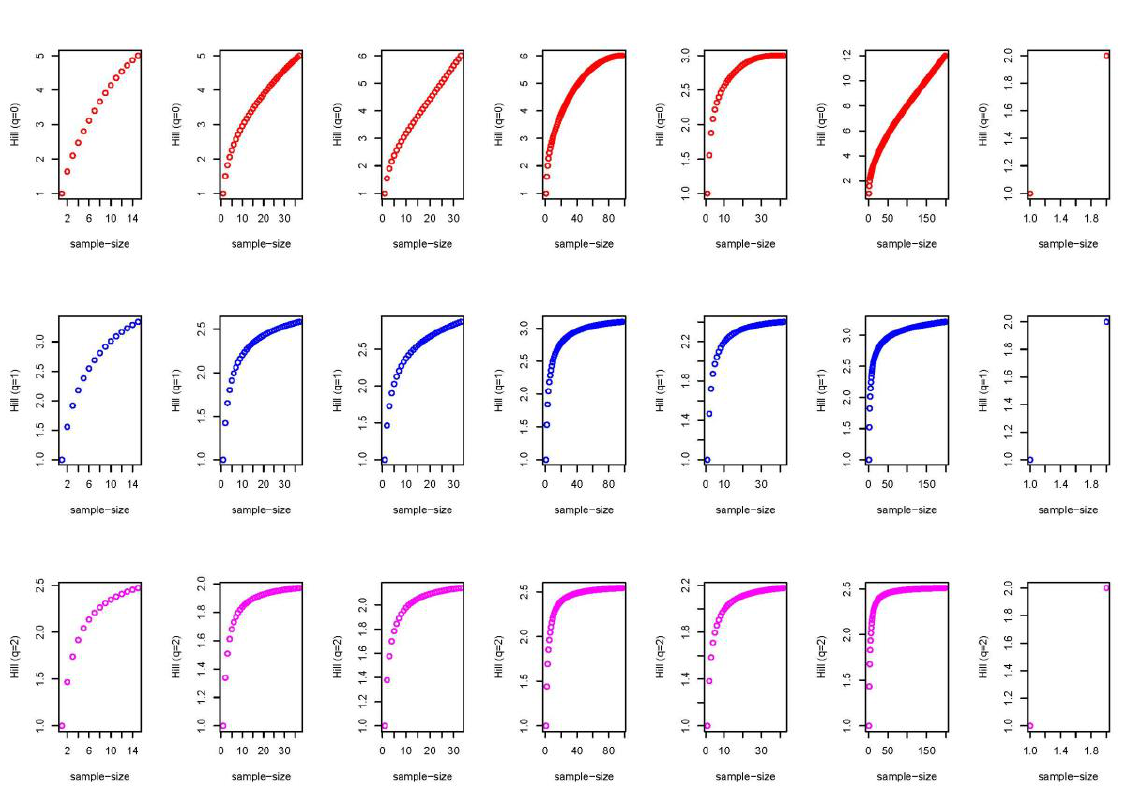
Figure 4: Individual rarefaction curves for Layers 2-8 (columns) for q = 1,2,3 (rows). X-axis represents the sample size in NISP, y-axis are Hill